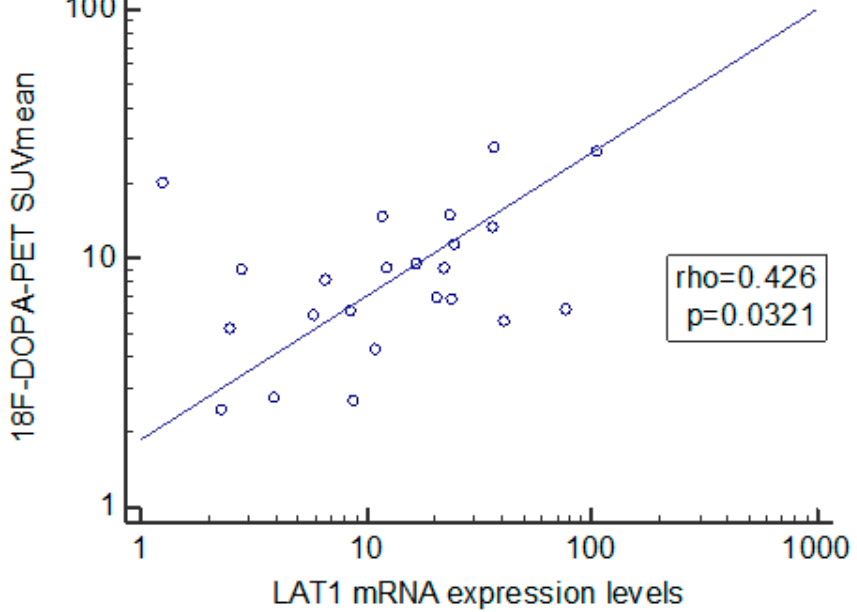
Figure 3. Spearman’s rank correlation coefficient analysis of L-type amino acid transporter 1 and 18 F-dihydroxyphenylalanine—positron emission tomography.